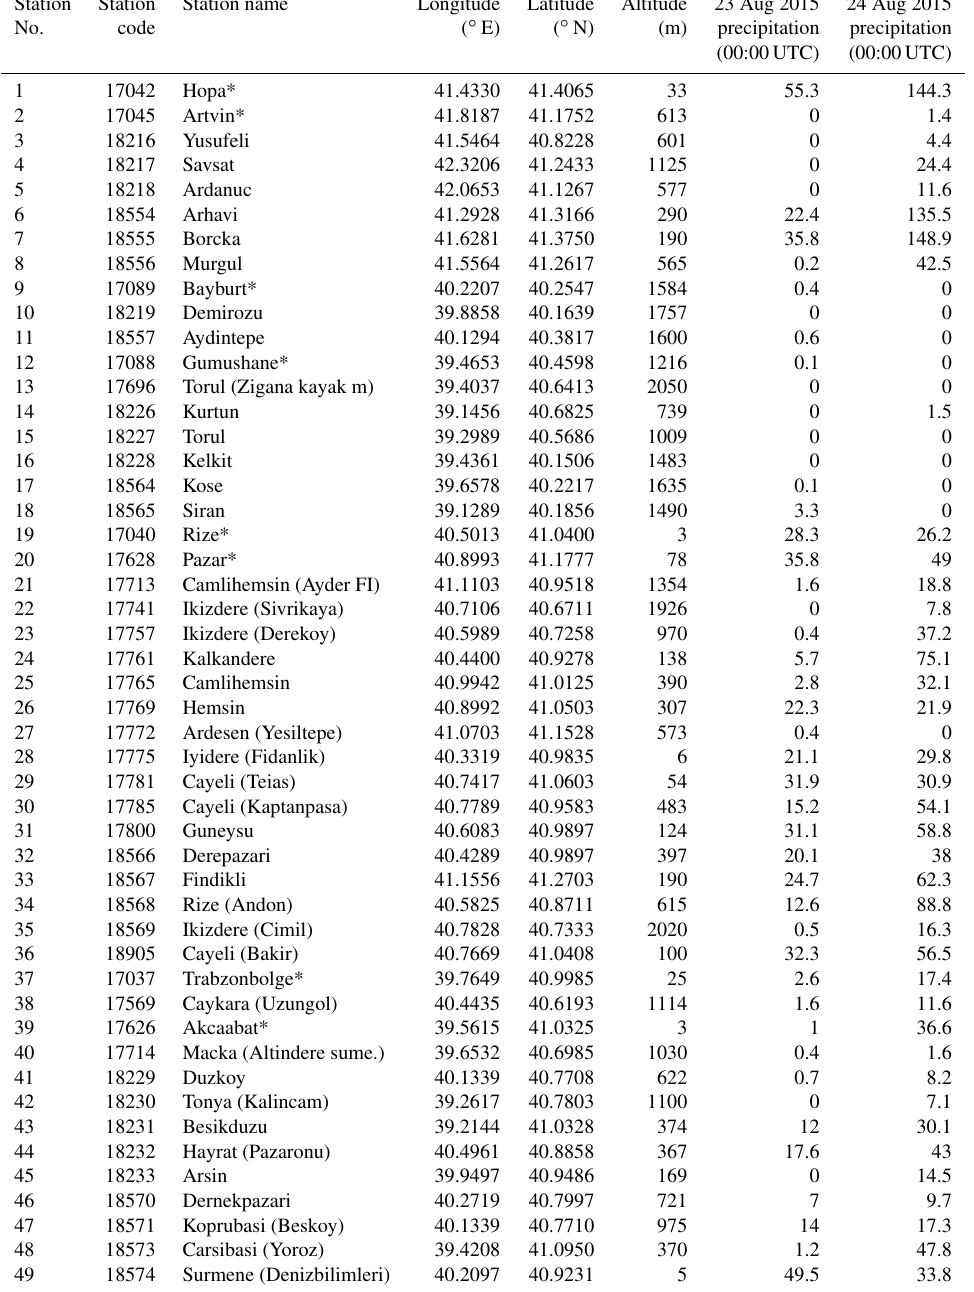
Table 1. Description of 49 meteorological stations in the study. Stations marked by stars were used for the climatological approach.